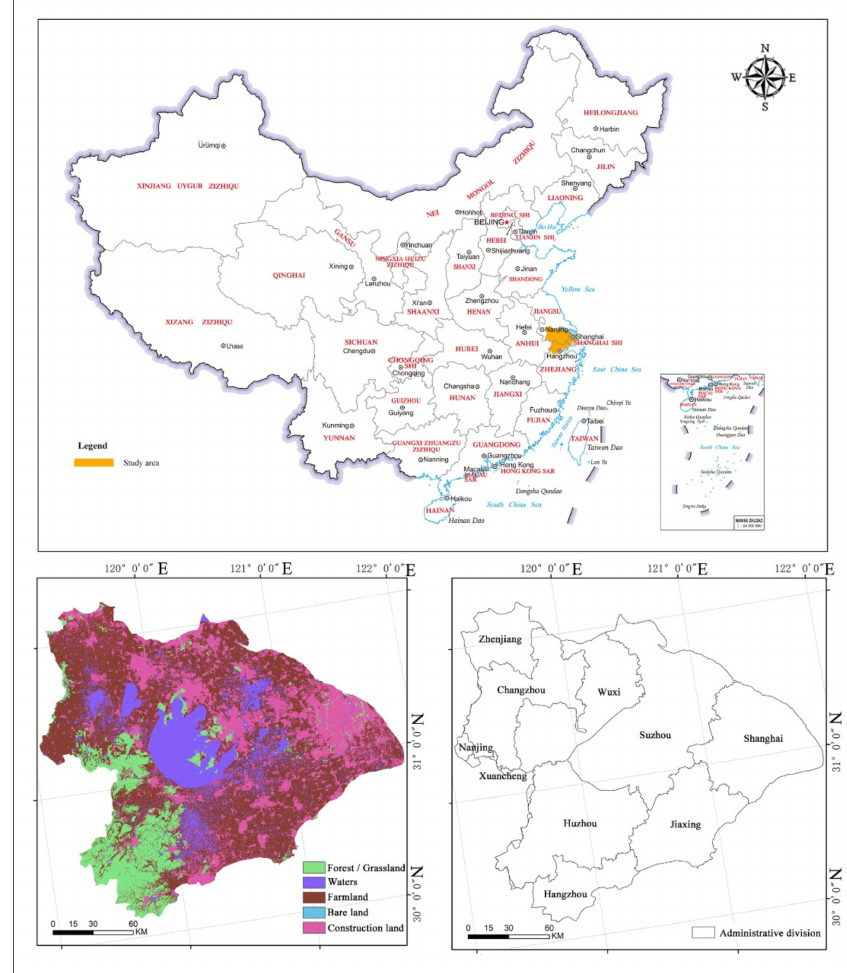
Figure 1. Location and distribution of different forms of land-cover around the Taihu Lake Basin